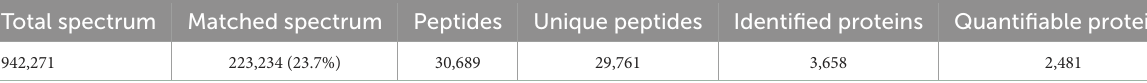
TABLE 1 MS/MS spectrum database search analysis summary.